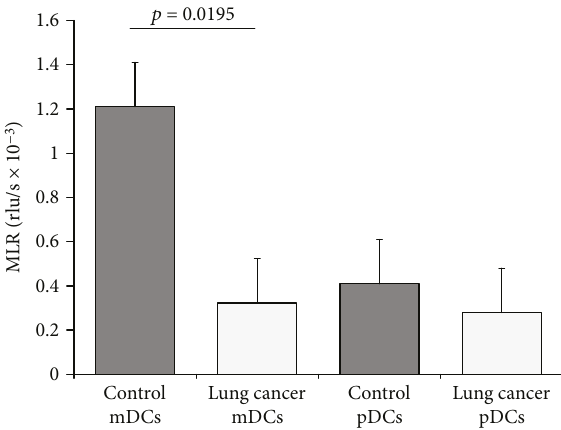
Figure 8: Quantitation of intracellular triglycerides in DCs. Lineage( − ), HLA-DR(+), CD11c(+), and CD123( − ) mDC fractions and Lineage( − ), HLA-DR(+), and CD123( − ) pDC fractions were sorted in the peripheral blood from the stage IV lung cancer patients and controls, and the cells were lysed to quantify the intracellular triglycerides. The intracellular triglyceride levels in mDCs were signi fi cantly higher in the lung cancer patients ( n = 3 ) than in the controls ( n = 4